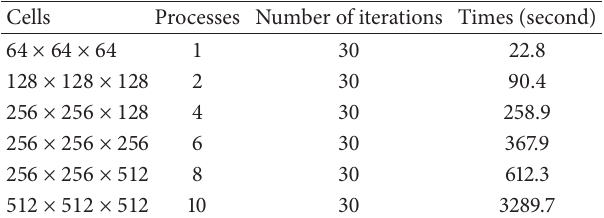
Table 2: Performance test.